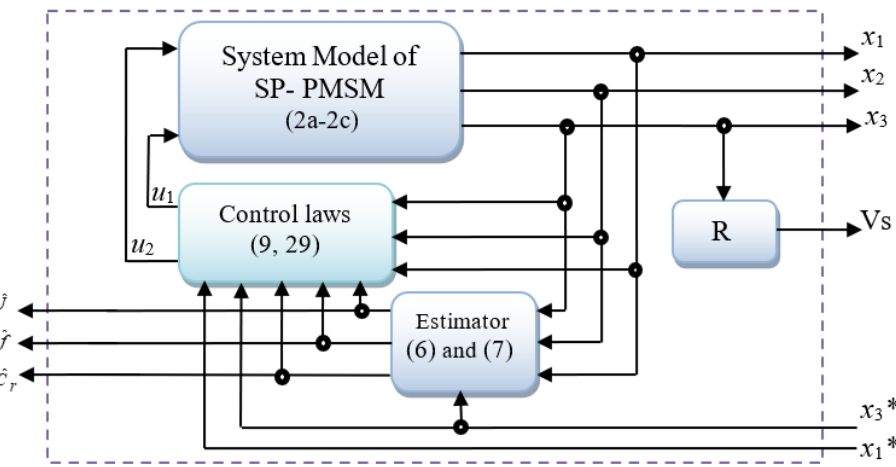
Figure 1. The SP-PMSM and control-system schematic diagram. Where V s = R x 3 : Vehicle Speed Figure 1. The SP ‐ PMSM and control ‐ system schematic diagram. Where V s = R x 3 : Vehicle Speed (m/s); R = 0.29 m: Radius of the point’s trajectory (m/s); R = 0,29m: Radius of the point’s trajectory (m) .